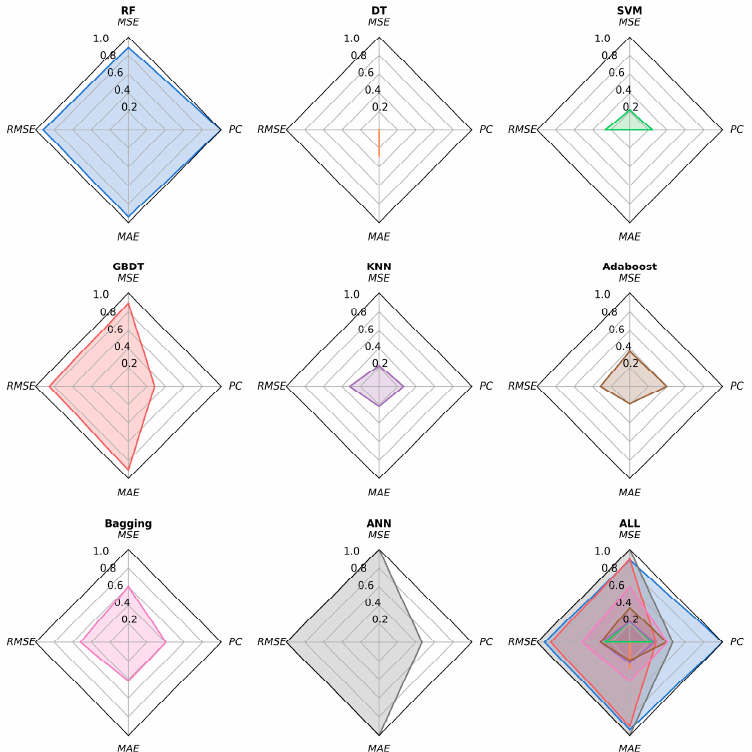
Figure 7. Evaluation index distribution radar diagram of the eight machine learning methods. Table 4. Ranking results based on entropy weight-TOPSIS method.